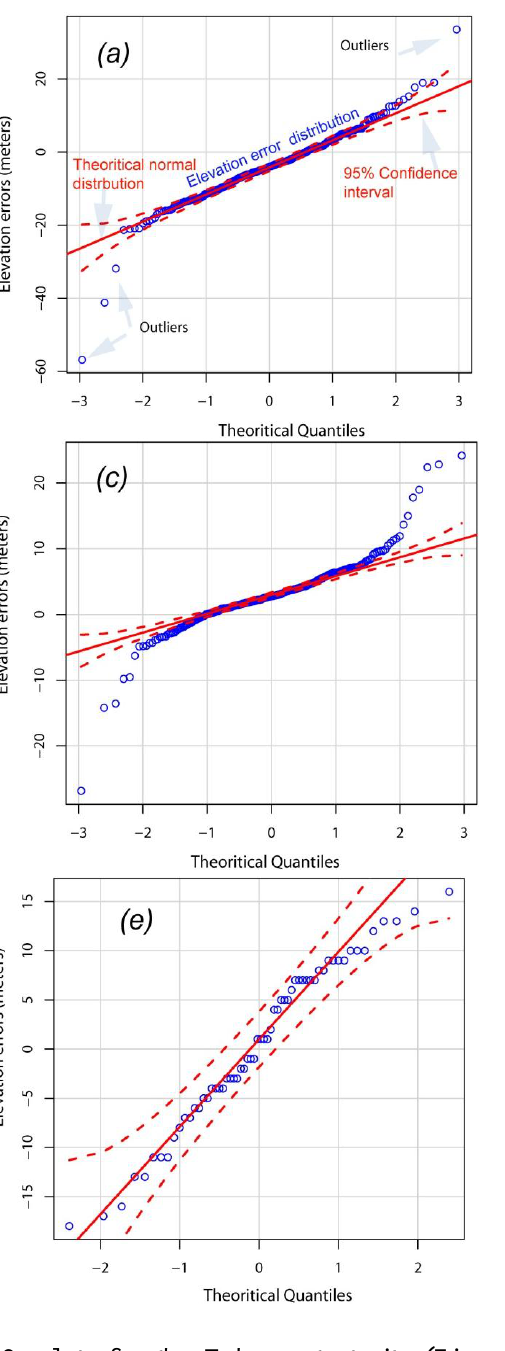
Figure 9. Q-Q plots for the Anaguid test site (a, b and c) showing the error distribution for ( a ) ASTER GDEM2, ( b ) SRTM v4.1 and ( c ) GMTED2010. Q-Q plots for the Tebessa test site showing the error distribution for ( d ) ASTER GDEM2, ( e ) SRTM v4.1 and ( f ) GMTED2010. The solid and dashed red lines represent theoretical normal distribution and 95% confidence intervals,